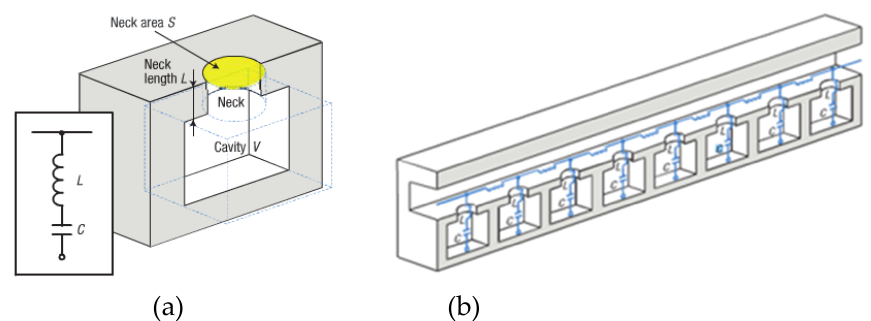
Figure 8. The schematic diagram of proposed structures: ( a ) One-dimensional Helmholtz resonator; ( b ) Helmholtz resonator composed of periodic arrangements [38].